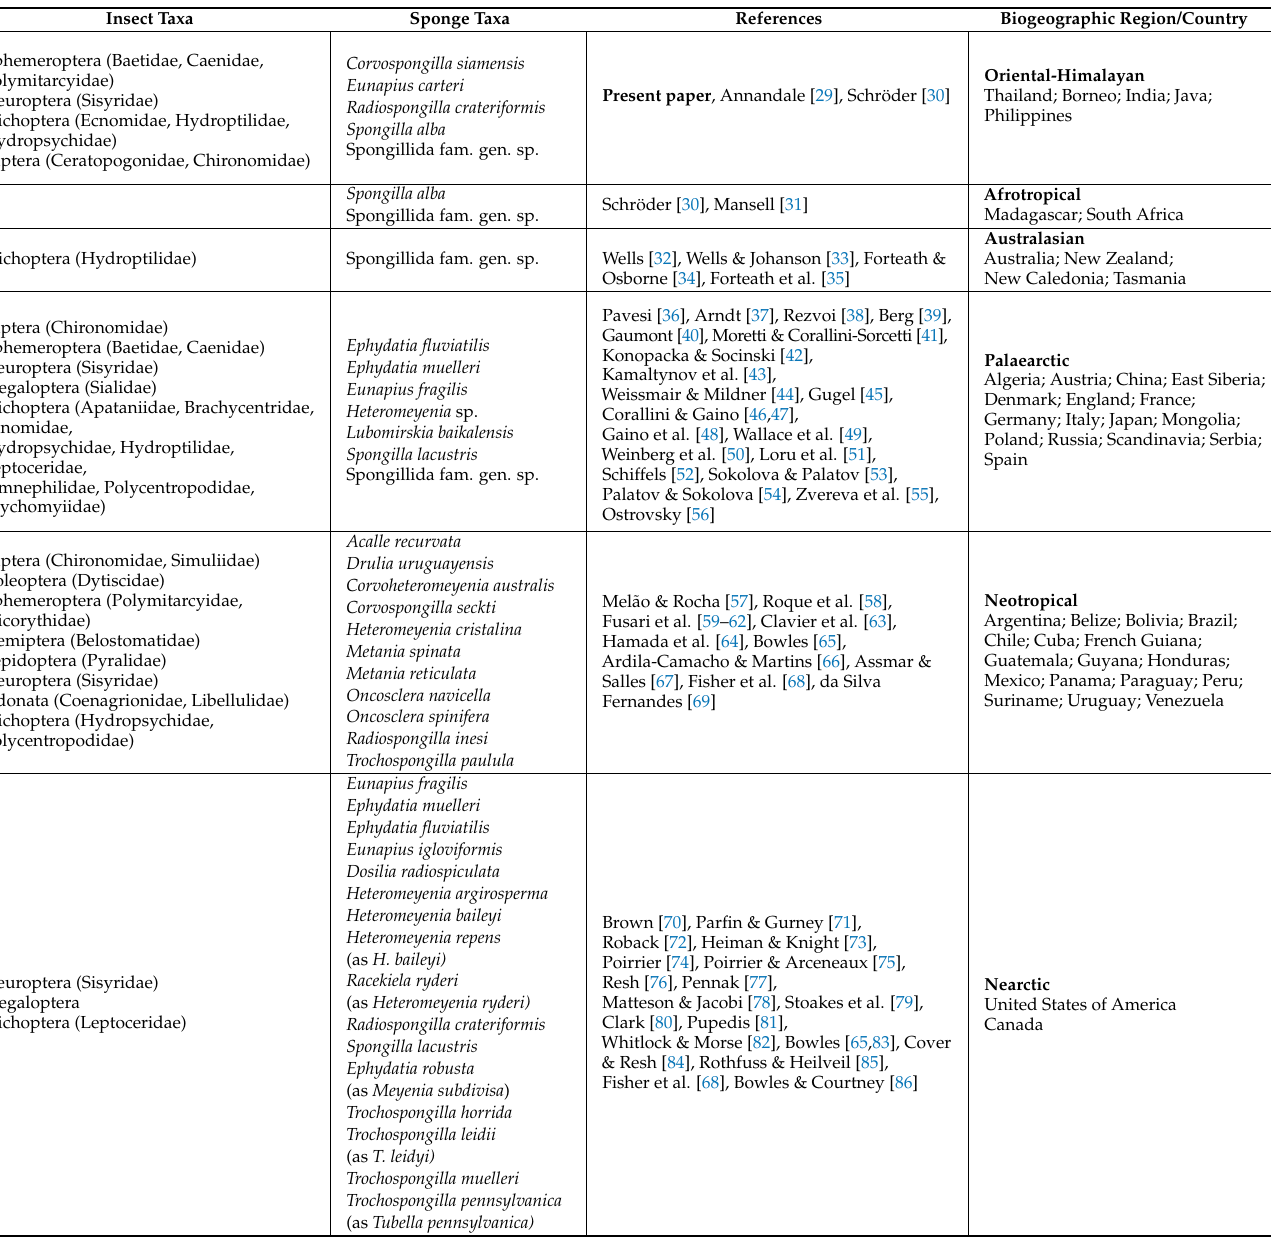
Table 2. Worldwide inventory of aquatic Insecta inhabiting Spongillida (Porifera) so far reported. Sponge species belong to families Lubomirskiidae, Metaniidae, Potamolepidae, and Spongillidae. Taxa and countries listed in alphabetical order. References listed in chronological